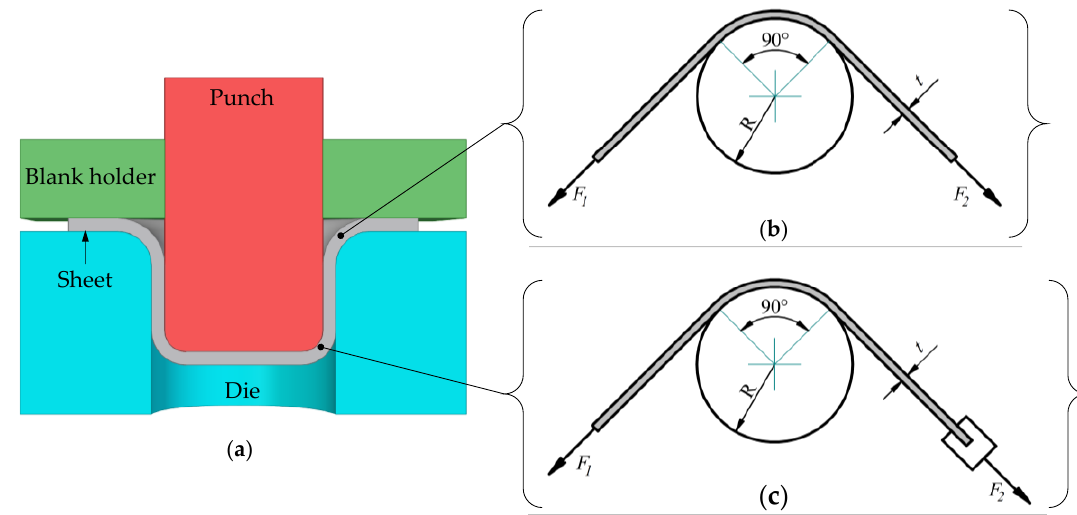
Figure 3. Schematic representation: ( a ) deep drawing process; ( b ) BUT test; ( c ) STT test.